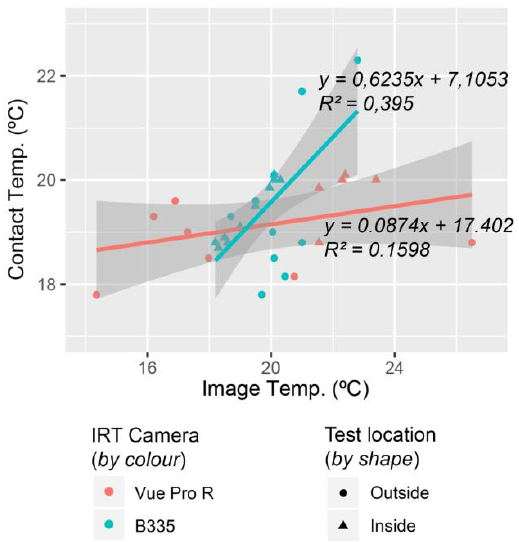
Figure 8. Image-based surface temperature (ST) values vs. contact measurements (PT 56C) for 20 image samples. *The FLIR Vue Pro R camera was disassembled from the quadcopter to take indoor images. The pole-mounted B335 camera obtained ST values with a bit more correlation (R2 = 0.39)